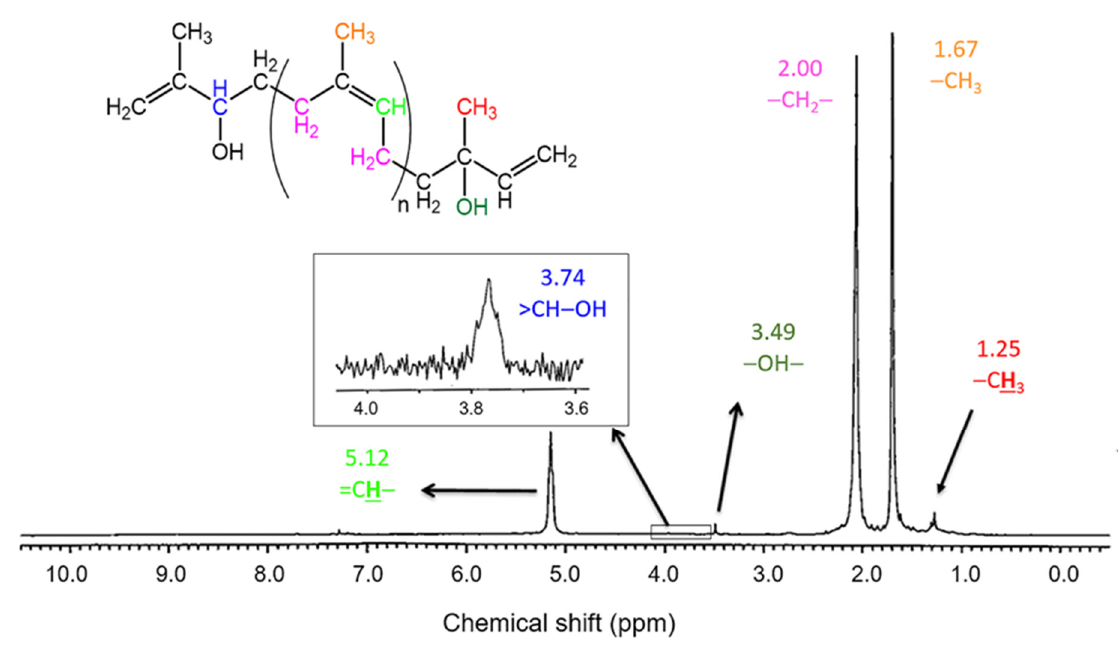
Figure 9. 1 H-NMR spectrum of FLNR prepared by SPNR in the presence of 2.0 phr of TiO 2 powder and 20% w / w H 2 O 2 under UVC-irradiation for 5 h.